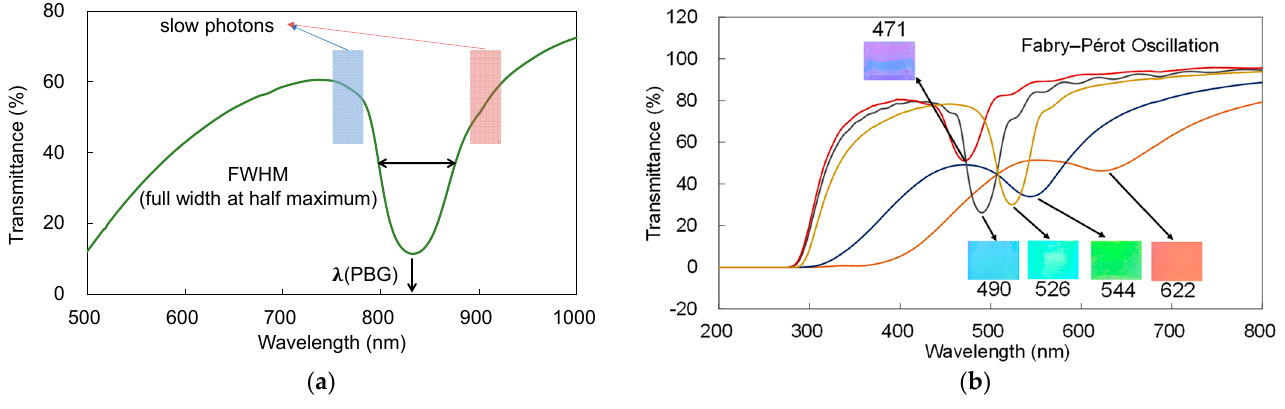
Figure 3. ( a ) The characterization of optical properties of PCs based on transmittance spectrum; ( b ) transmittance spectra and respective photos of silica opals with different sizes of silica particle (PBG wavelengths written near photos). Table 1. Properties of silica opals with different silica sizes.